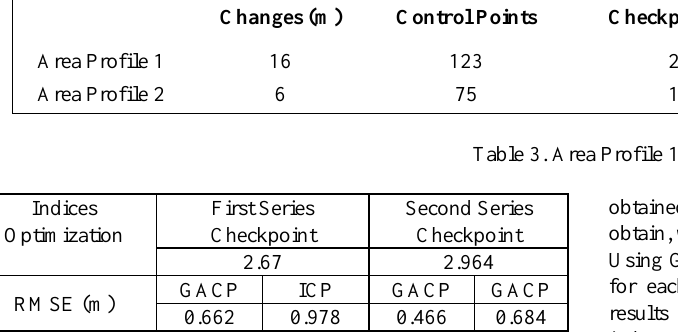
Table 4. Results Obtained from IDW Method